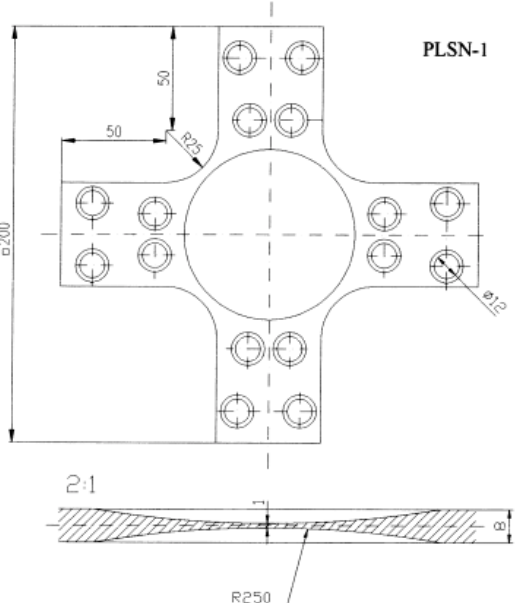
Figure 6. Plate specimens with cruciform geometry (reprinted from [33], with permission from Elsevier, 1999).